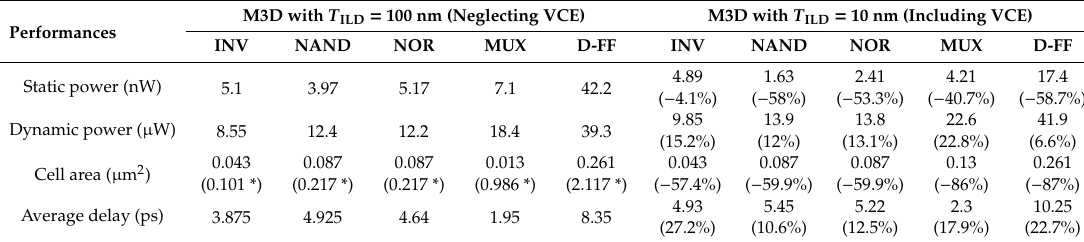
Table 3. Performance comparison of M3DI logics with/without electrical coupling.